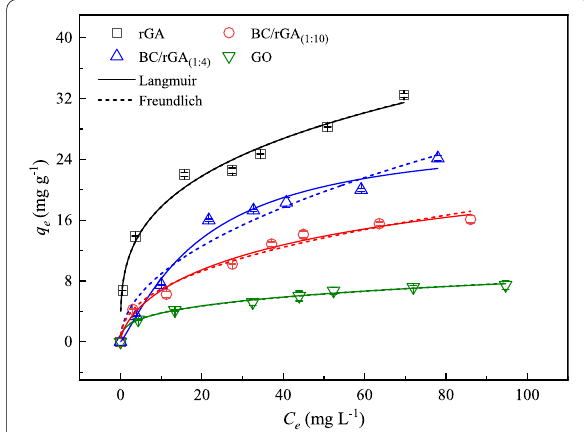
Fig. 5 Adsorption isotherm fitting of Cr(VI) on GO and aerogels